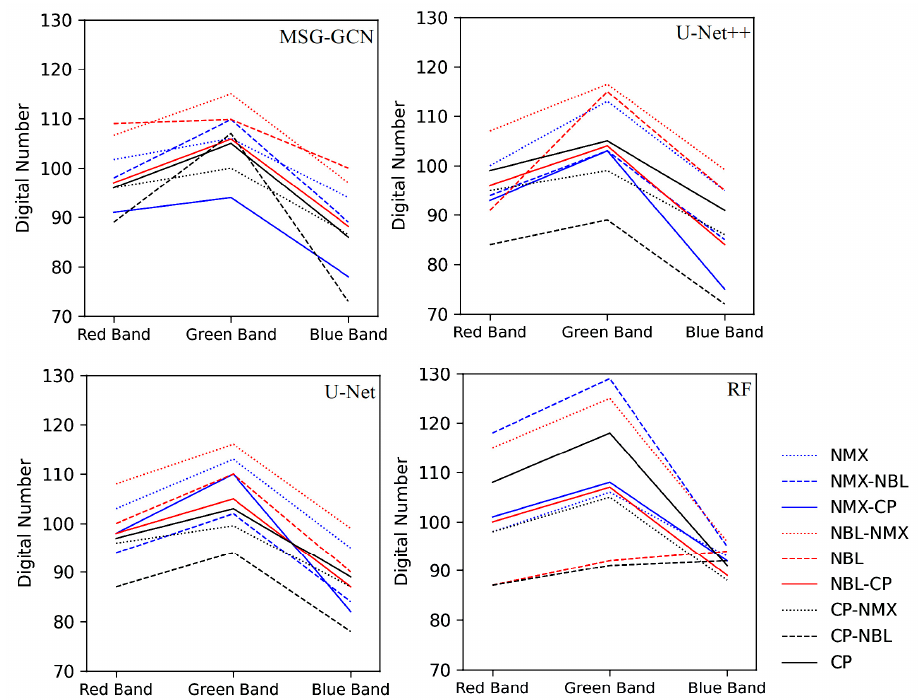
Figure 4. Mean digital numbers (DNs) of forest types correctly classified and misclassified by different models.